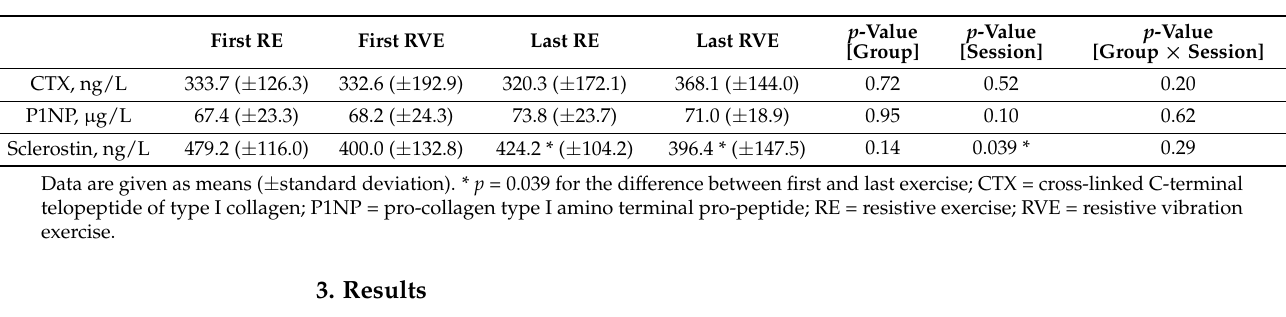
Table 2. Resting baseline levels of bone markers before the first and last exercise sessions for resistive exercise (RE) and resistive vibration exercise